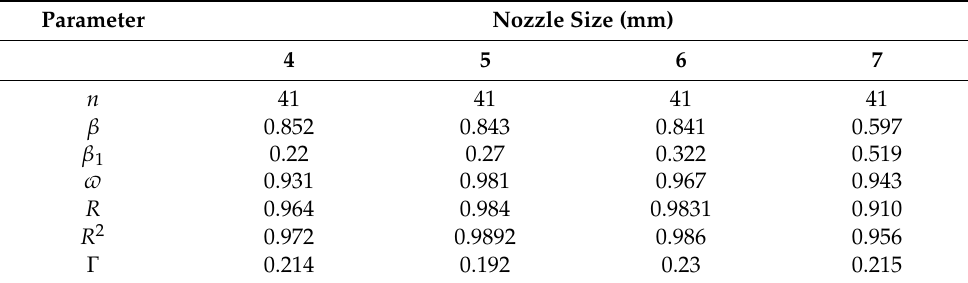
Table 2. Indices of the different orifice shapes in predicting droplet diameter.